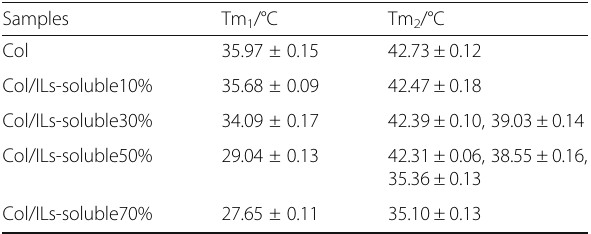
Table 2 Thermodynamic parameters of Col and collagen samples dissolved in different concentrations of [EMIM][Ac] a